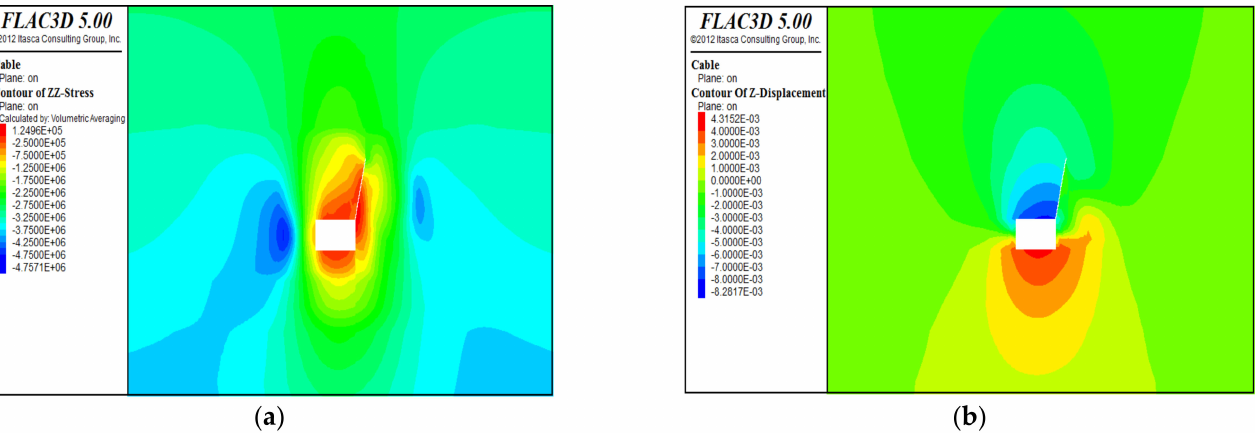
Figure 5. Vertical stress and displacement distribution at 10 m in front of the working face: ( a ) vertical stress distribution diagram; ( b ) vertical displacement distribution diagram.